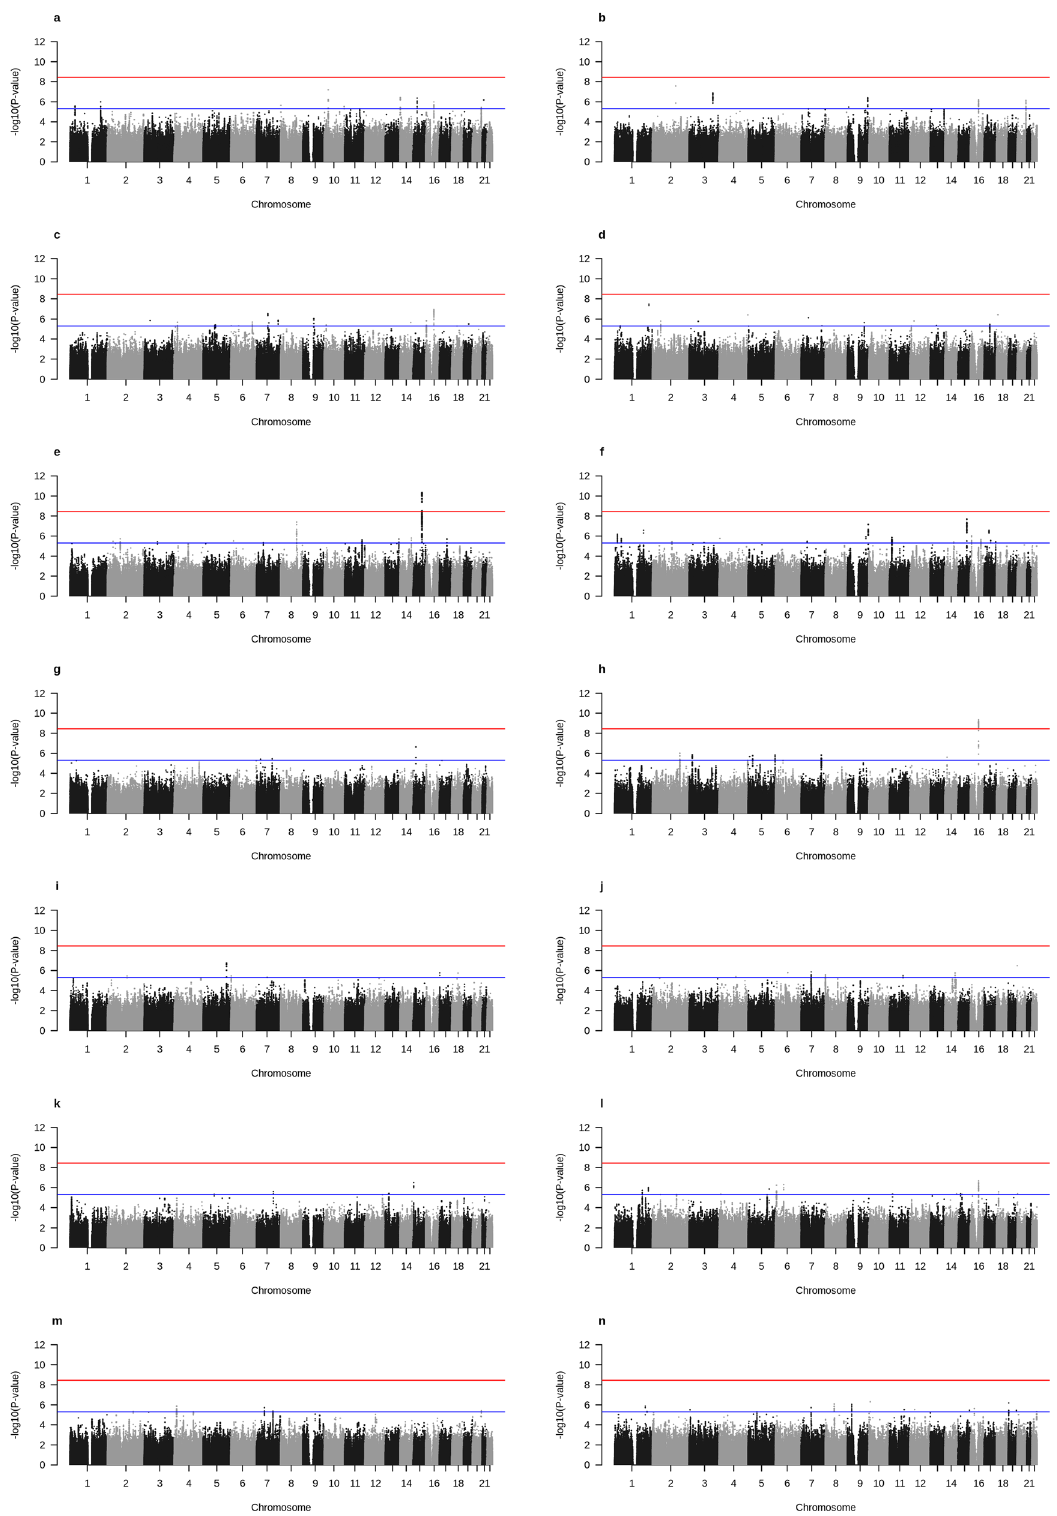
Fig. 1 Manhattan plots of gene-environment interaction study. Manhattan plots showing the – log 10 -transformed gene-environment interaction P -value of each SNP on the y -axis and base-pair positions along the chromosomes on the x -axis. SNP P -values were computed in Plink 1.90. The blue line indicates the suggestive threshold ( P < 5.00 × 10 − 6 ). The red line indicates the genome-wide signi fi cance for multiple testing ( P < 3.57 × 10 − 9 ). a Metabolic equivalent task (MET) score, b Moderate physical activity, c Time spent wathcing television (TV), d Time spent using computer, e Smoking status, f Pack years of smoking, g Alcohol intake status (the GWIS after genomic control), h Alcohol intake frequency (the GWIS after genomic control), i Neuroticism score, j Fed-up feelings, k Sleep duration (the GWIS after genomic control), l Nap during day, m Average total household income before tax, n Townsen deprivation index at recruitment.